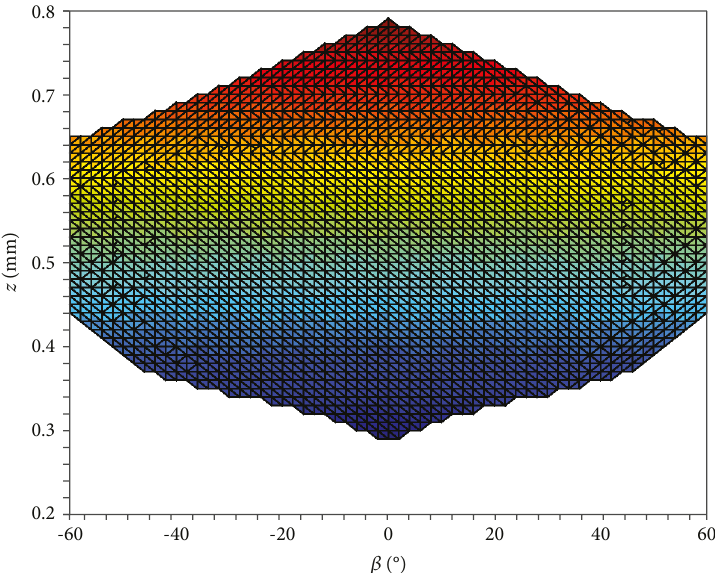
Figure 12: The two-dimensional view of the operation workspace of the parallel